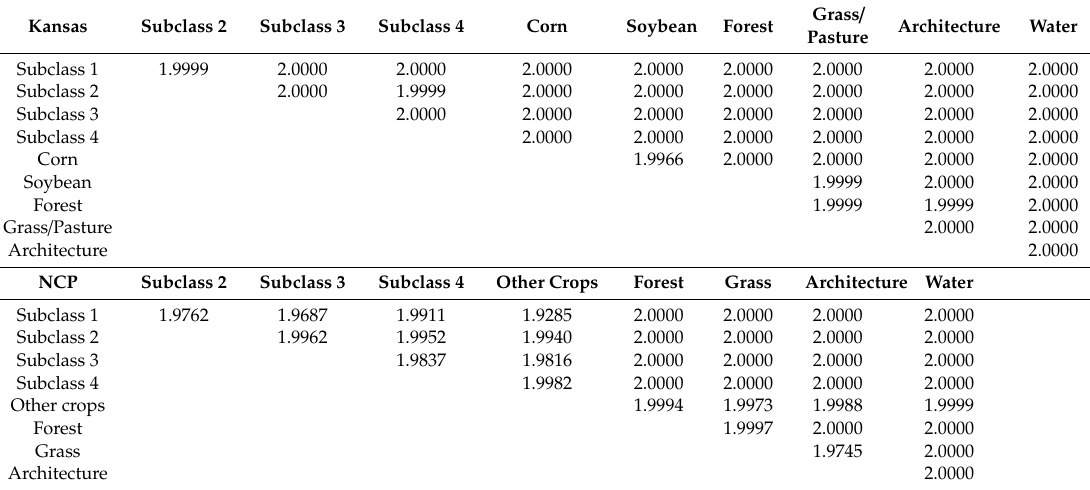
Table 6. Je ff ries–Matusita (JM) distances for all pairs in Kansas and the